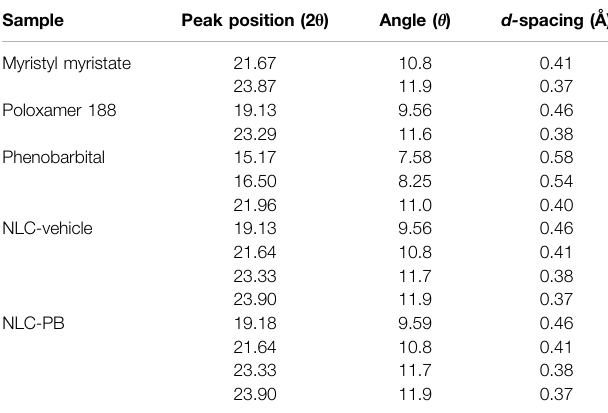
TABLE 5 | Peaks position and d- spacings of raw materials and NPs with and without PB were measured by XRD at λ = 0.154 nm. Sample Peak position (2 θ ) Angle ( θ ) d- spacing (Å) Myristyl